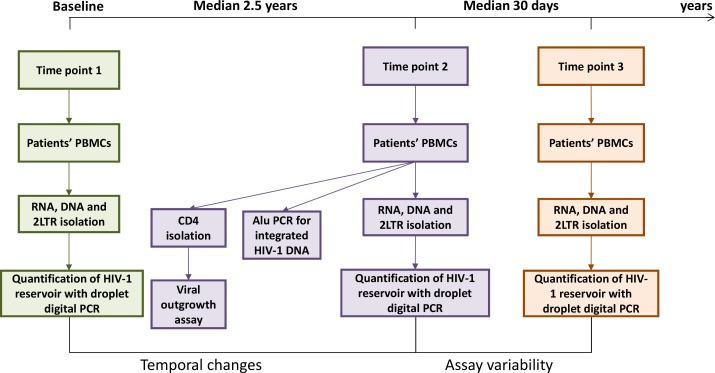
Workflow schematics.